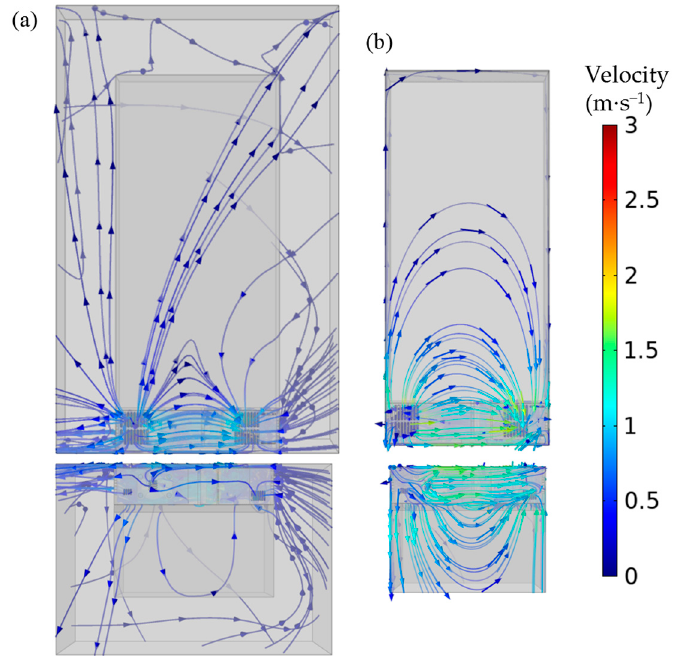
Figure 6. Velocity vectors and streamlines of the refrigerator for two configurations (m·s − 1 ): ( a ) free-standing and ( b ) built-in.